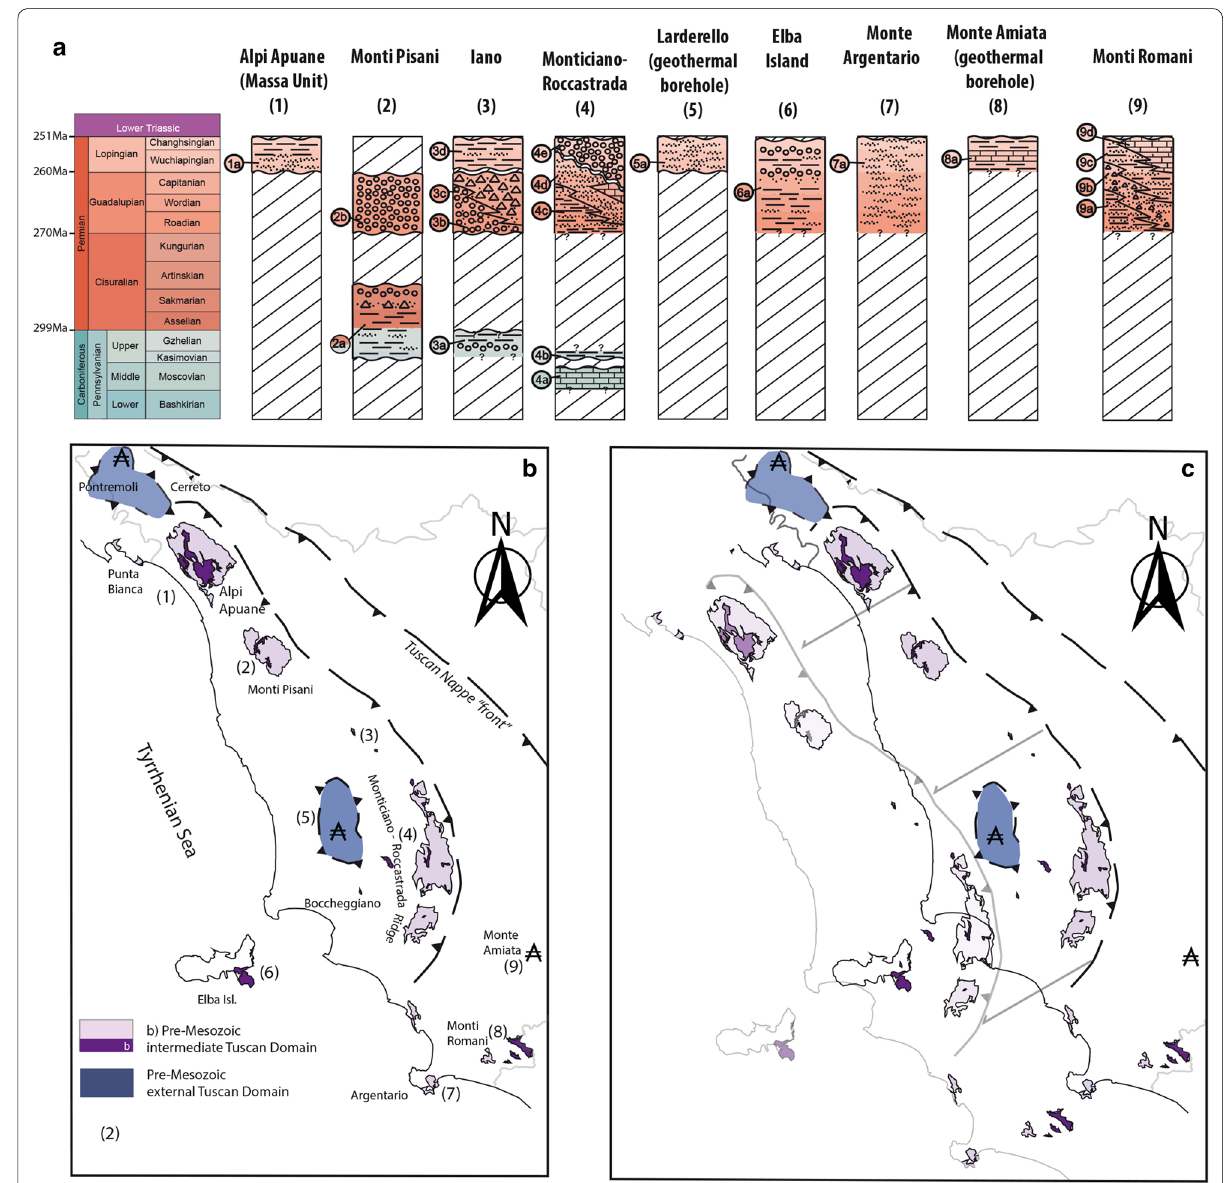
Fig. 5 a Upper Carboniferous-Permian successions of the intermediate pre-Mesozoic “Tuscan” domain. Alpi Apuane: 1a—Montignoso Fm; Monti Pisani: 2a – Scisti di San Lorenzo Fm; 2b—Breccia di Asciano Fm; Middle Tuscan Ridge: 3a – Scisti di Iano Fm; 3b—Breccia e Conglomerati di Torri Fm; 3c – Scisti Porfirici Fm; 3d—Fosso del Fregione Fm; 4a—Calcare di Sant’Antonio Fm; 4b—Scisti a Spirifer Fm; 4c—Farma Fm—Falsacqua Fm; 4d—Carpineta Fm—Quarziti di Poggio alle Pigne Fm; 4e—Arenarie di Poggio al Carpino Fm—Le Cetine Fm.- Conglomerato di Fosso Pianacce